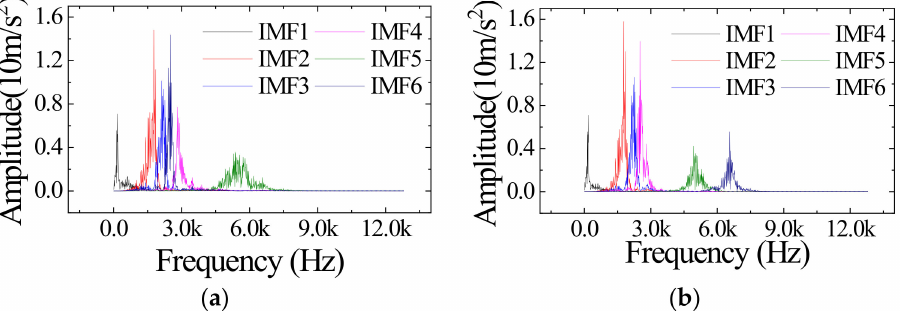
Figure 6. Frequency domain image of the decomposed IMFs. ( a ) Result of VMD. ( b ) Result of IVMD.